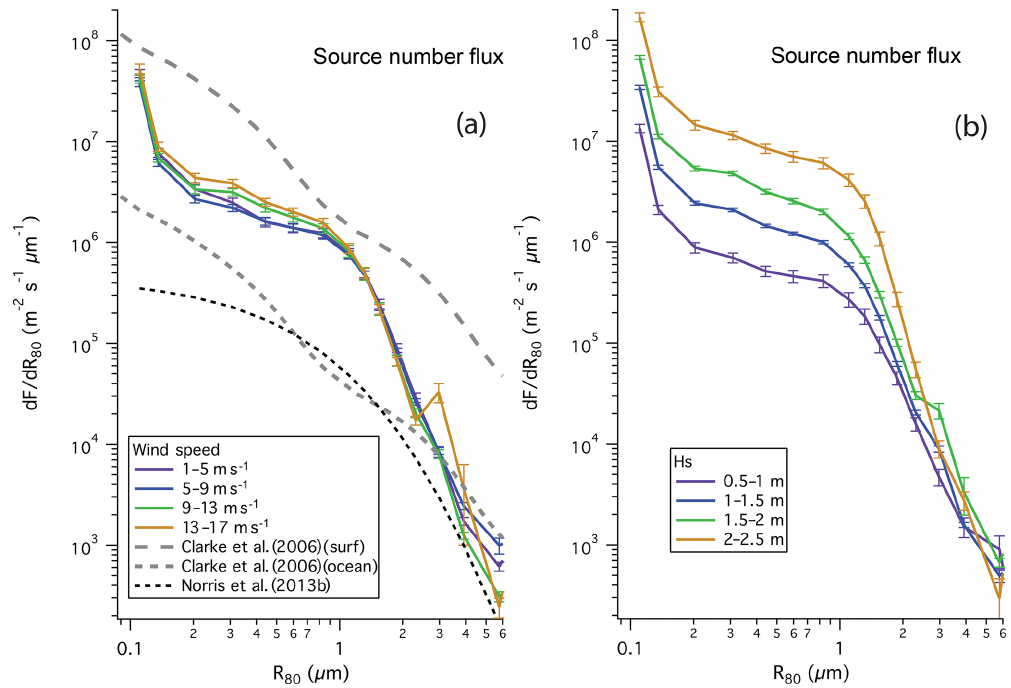
Figure 11. Size-distributed source number flux from the CLASP, bin-averaged according to wind speed (a) and significant wave height (b) . Data are limited to the southwest (open water) wind sector only. The open ocean source flux parameterizations from Clarke et al. (2006) and Norris et al. (2013b) are approximated at a wind speed of 10ms − 1 , while the measured surf zone flux from Clarke et al. (2006) is more than an order of magnitude higher. Error bars indicate standard errors. Radius adjusted from ambient humidity to a relative humidity of